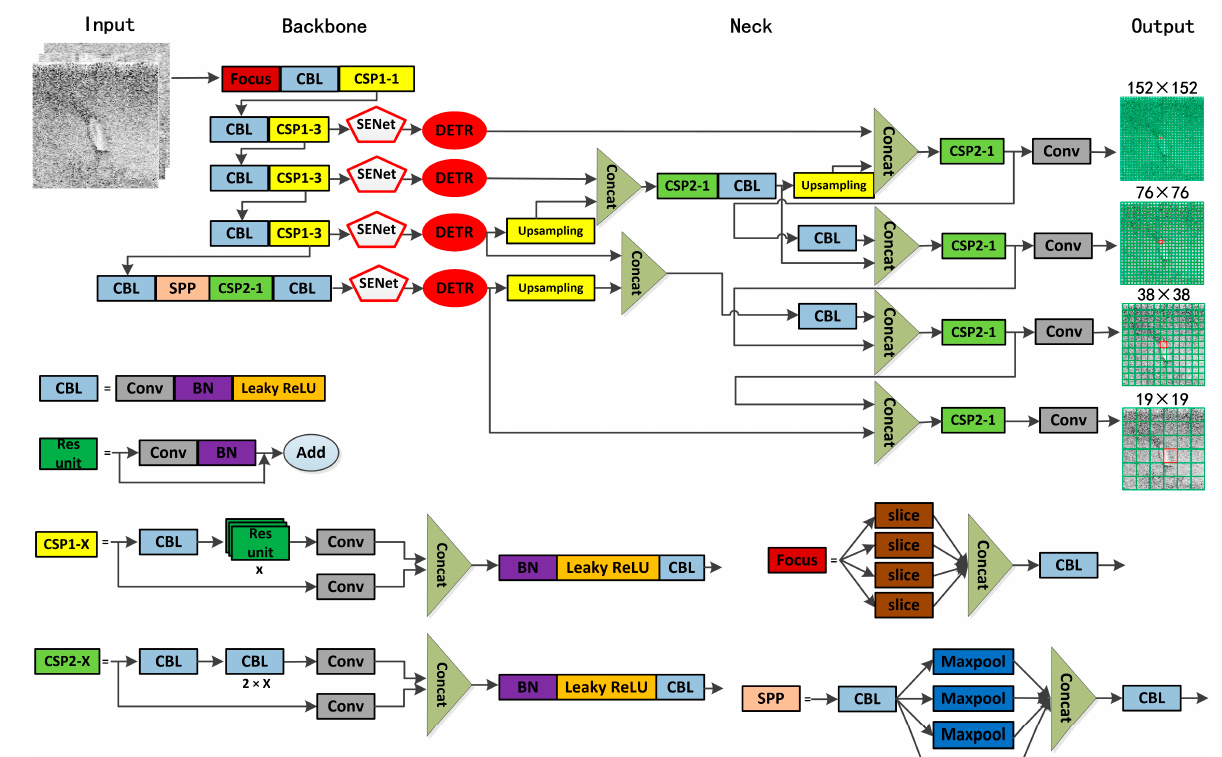
Figure 6. Structure of the DETR-YOLO model.